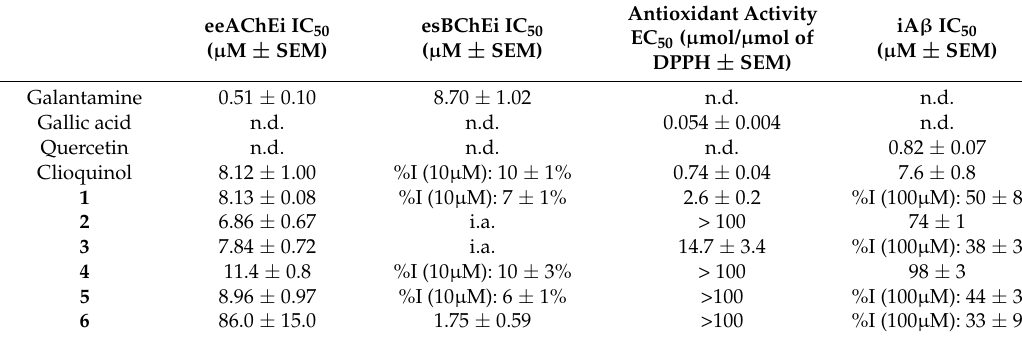
Table 1. Biological assays on compounds 1 to 6